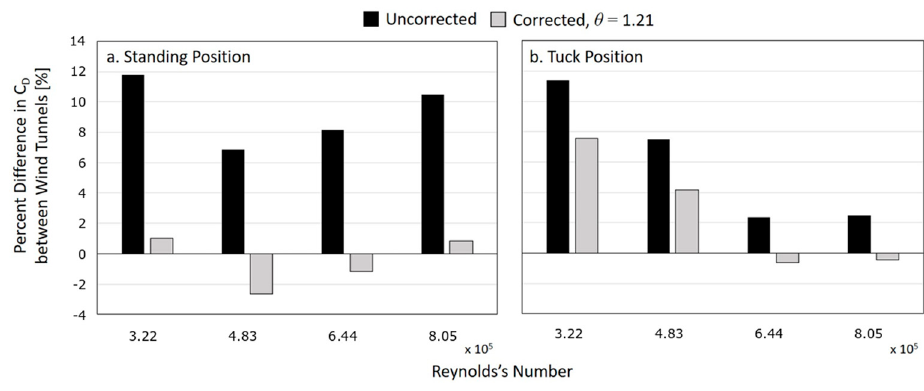
Figure 3. The effect of blockage correction ( θ = 1.21) on the percentage difference in C D between the two wind tunnels for both the Standing ( a ) and Tuck ( b ) positions. The measured points correspond to measurements at every 5 m/s from 10 to 25